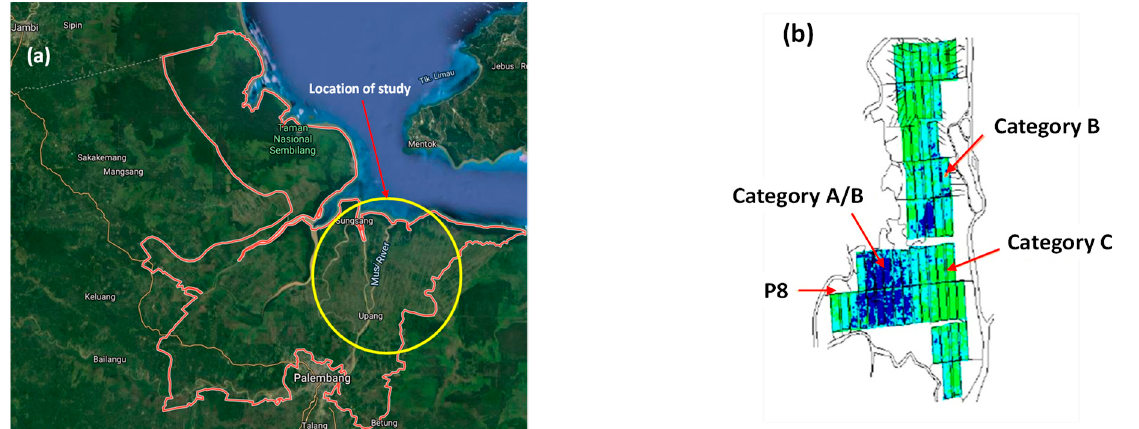
Figure 1. ( a ) The investigated location in this study; ( b ) Layout of the investigated primary channel 8 (P8).